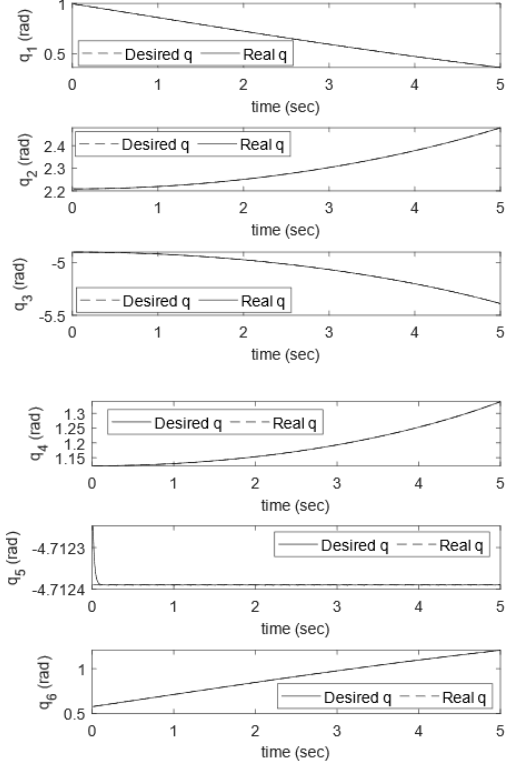
Figure 2. Joint angle behavior of UR5 using the proposed control approach.